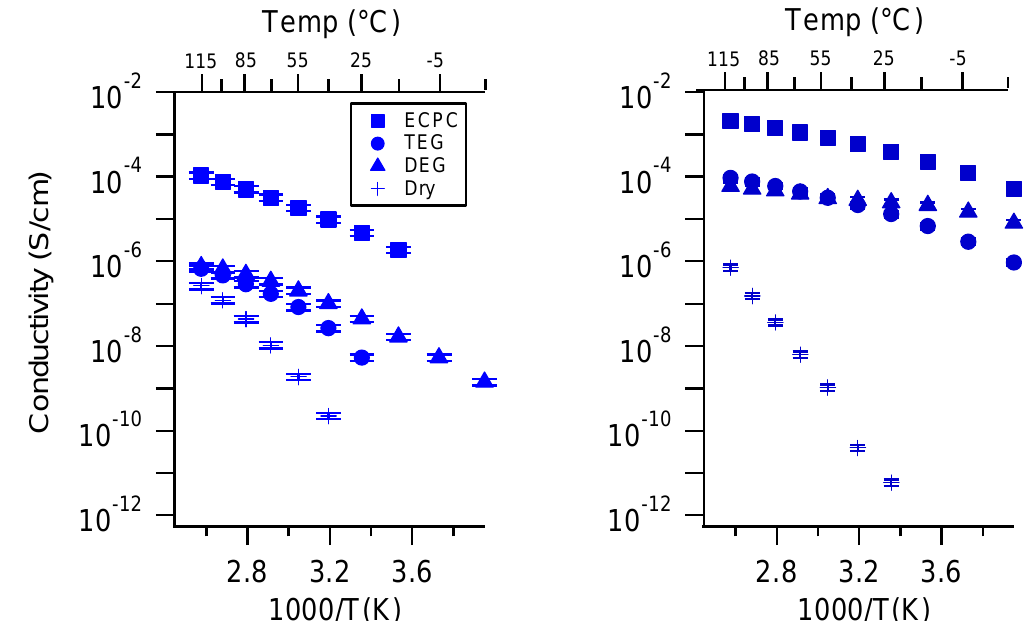
Figure A30. Conductivity as a function of solvent for PEGDMA1000_high_SSNa (left) and PTHFDA1000_high_STFSINa (right) SIPEs. Temperatures ranged from − 20 °C to 115 °C. Note that there may be a non ‐ negligible fraction of electronic conductivity in conditions where conductivity of less than 10 − 9 S/cm is reported.